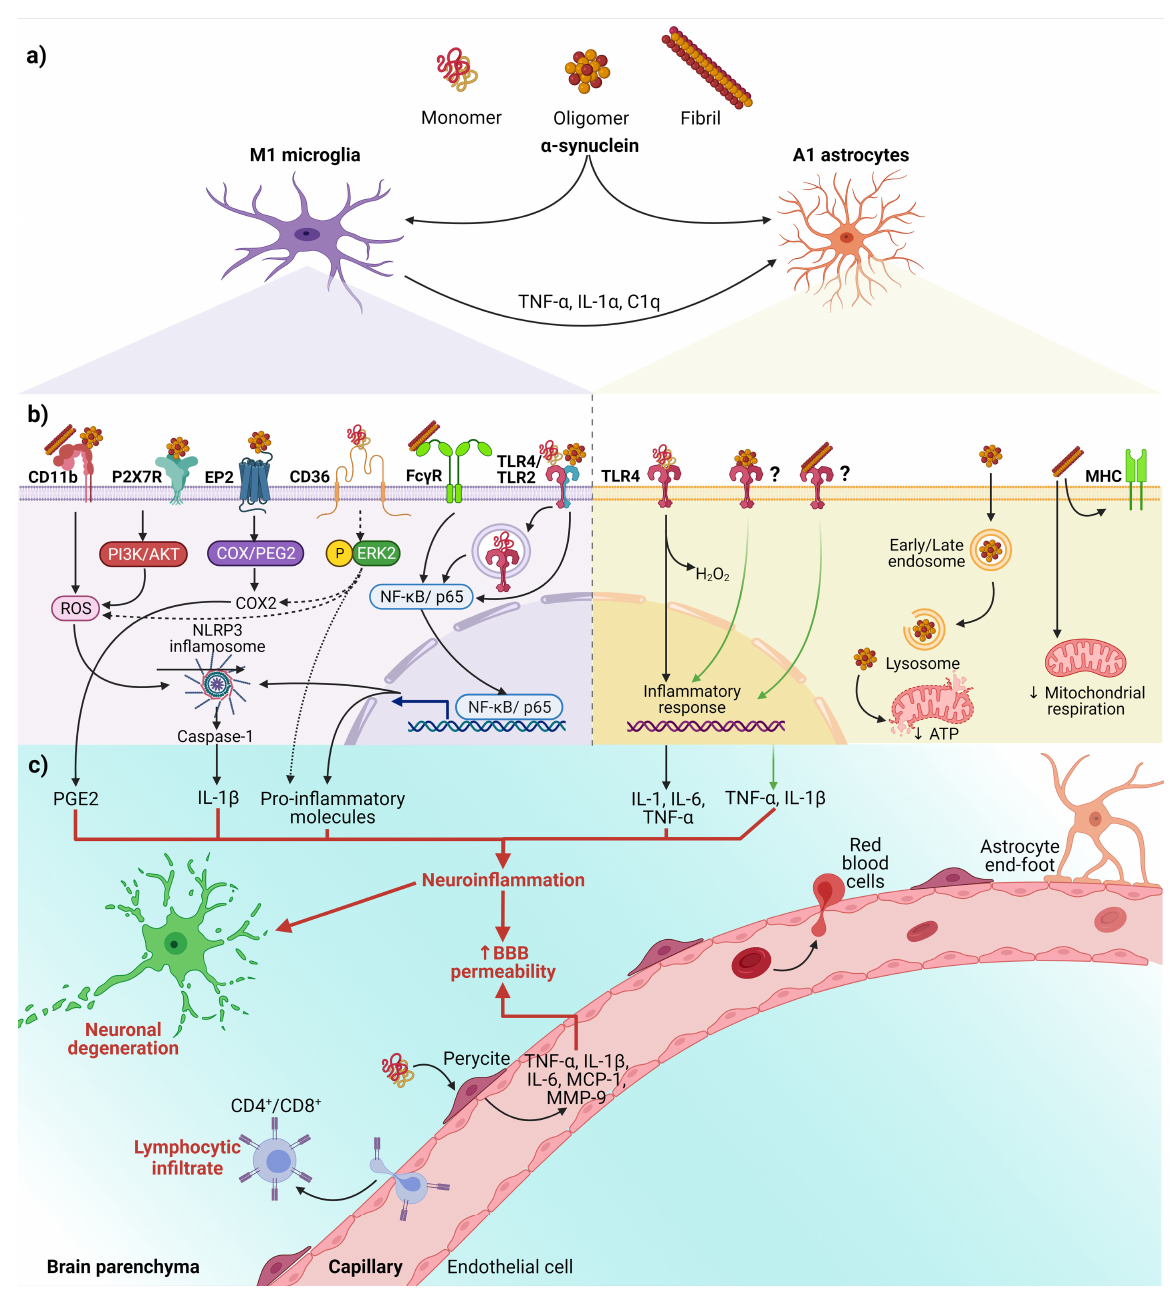
Figure 2. The interaction between α -syn and neuroinflammation in PD. ( a ) Activation of glial cells by pathological α -syn aggregates; ( b ) Signaling pathways in microglia and astrocytes triggered by interaction with the different aggregation patterns of α -syn; ( c ) Neuronal and BBB dysfunction triggered by the neuroinflammatory environment. Dash lines indicate the signaling pathway activated by CD36; Question marks and faded green lines indicate the proposed mechanism for oligomeric and fibrillar α -syn interaction with astrocytes, and thick red lines indicate the proinflammatory molecules that lead to dysfunction of the BBB and neural degeneration. Abbreviations: AKT, Protein kinase B; BBB, Blood-brain barrier; C1q, complement component 1q; CD, cluster of differentiation; COX, cyclooxygenase; EP2, E prostanoid receptor 2; ERK2, extracellular signal-regulated kinase 2; Fc γ R, the gamma chain subunit of Fc receptor; H 2 O 2 , hydrogen peroxide; IL, interleukin; MCP-1, Monocyte Chemoattractant Protein-1; MHC, Major Histocompatibility Complex; MMP-9, Matrix metallopeptidase 9; NF- κ B, nuclear factor kappa-light-chain-enhancer of activated B cells; NLRP3, NLR family pyrin domain containing 3; P2X7R, P2X7 receptor; PGE2, Prostaglandin E2; PI3K, phosphoinositide 3-kinase; ROS, reactive oxygen species; TLR, Toll-like receptors; TNF- α , tumor necrosis factor-alpha. Created with